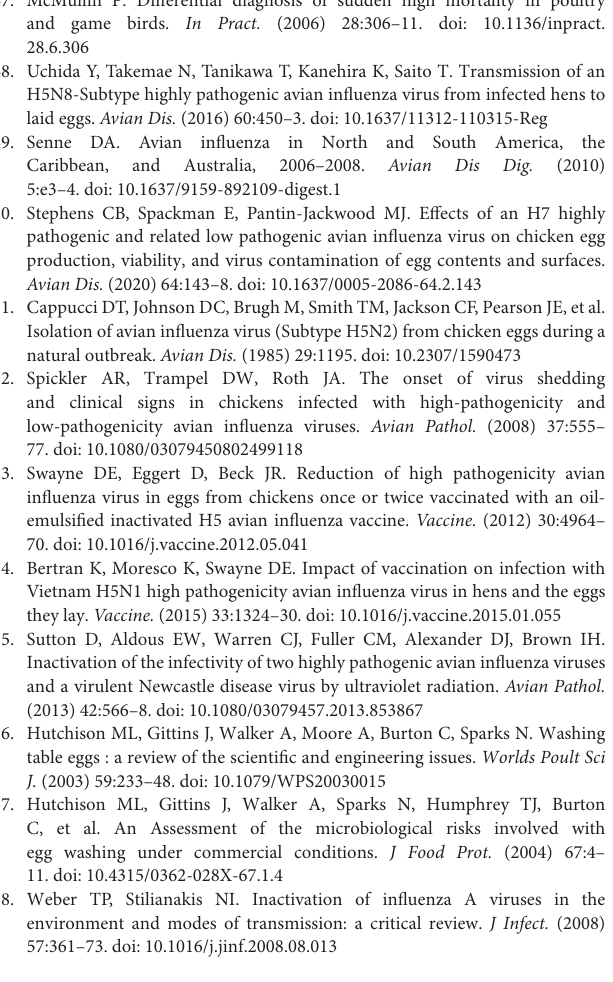
table eggs : a review of the scientific and engineering issues. Worlds Poult Sci J. (2003) 59:233–48. doi: 10.1079/WPS20030015 57. Hutchison ML, Gittins J, Walker A, Sparks N, Humphrey TJ, Burton C, et al. An Assessment of the microbiological risks involved